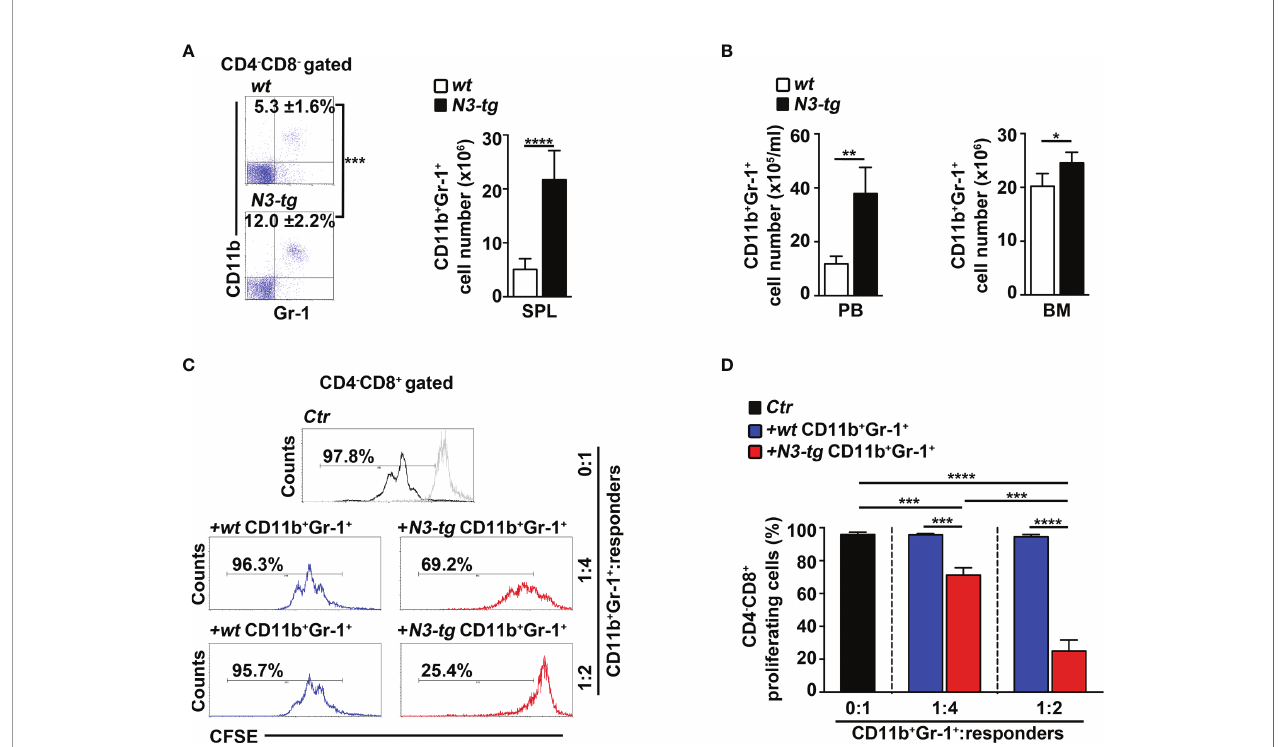
FIGURE 1 | CD11b + Gr-1 + MDSCs expand in N3-tg mice. (A) Percentages and absolute numbers of CD11b + Gr-1 + cells, as assessed by FACS analysis distribution of CD4 vs. CD8 vs. CD11b vs Gr-1 markers in spleen (SPL) of N3-tg and wt mice. Numbers inside cytograms indicate mean percentages ± SD of CD11b + Gr-1 + cells. The cytograms in this panel illustrate the percentages of CD11b + Gr-1 + splenocytes inside the CD4 − CD8 − subset, to avoid any possible dilution effect due to the presence of DP T cells in transgenic mice. (B) CD11b + Gr-1 + numbers in peripheral blood (PB) and BM from N3-tg vs. wt mice, assessed by FACS analysis, as in (A) . In (A, B) , the values are presented as mean ± SD of four independent experiments ( n = 6 mice per group). (C) Representative FACS analysis of suppression assay with CFSE-labeled/activated wt T splenocytes ( “ responders ” ), cultured either alone (Ctr), as a control, or in combination with CD11b + Gr-1 + “ putative ” MDSCs ( “ suppressors ” ). Numbers inside cytograms represent percentages of proliferating CD4 − CD8 + responder cells. Similar results were obtained by analyzing the proliferation rate of gated wt CD4 + CD8 − T responder cells (not shown). CD11b + Gr-1 + cells were sorted from spleen of N3-tg or wt mice and used at the indicated CD11b + Gr-1 + :responders ratio. The gray line represents nonactivated negative controls. In (D) , results of suppression test, as in (C) , are illustrated as mean values ± SD from three independent experiments ( n = 3 mice per group), with two technical replicates per experiment. All the mice were analyzed at 12 weeks of age. * p ≤ 0.05, ** p ≤ 0.01, *** p ≤ 0.001, and **** p ≤ 0.0001 represent signi fi cant differences between the indicated